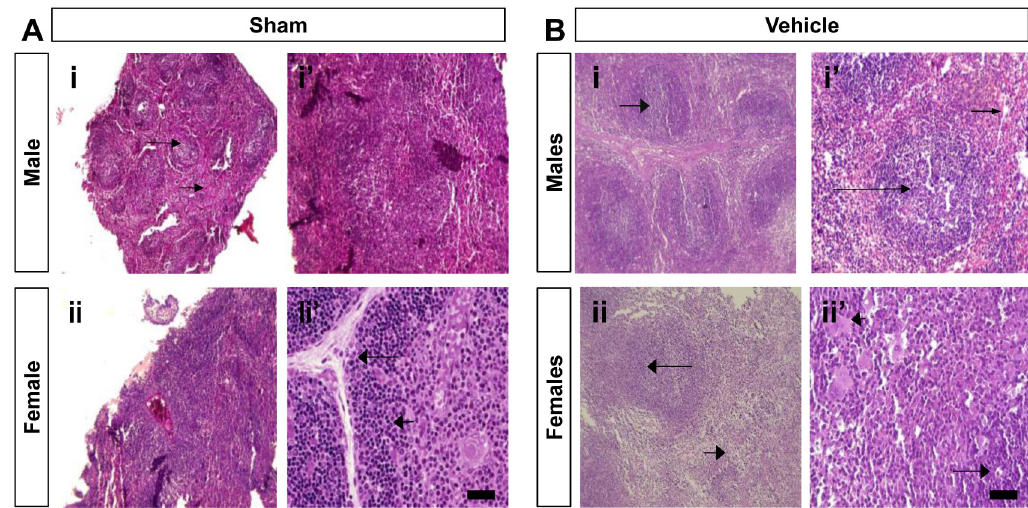
Fig 5. Histopathological analysis in hematoxylin and eosin (H&E) stained spleen of control and vehicle-treated mice (40 × ). (A) The splenic tissues of male and female control mice at lower magnification (panels Ai and ii) showed a typical structure of the spleen. The lymphatic nodules showed a prominent germinal center composed of the white pulp (long arrow) surrounded by splenic cords and venous sinuses composed of the red pulp (short arrow). The splenic tissues of male and female control mice (panels Ai’ and ii’) showed splenic trabeculae (long arrow) and lymphocytic aggregation and part of white pulp in the lymphatic nodules (short arrow). (B) The splenic tissue of male and female vehicle-treated mice at lower magnification (panels Bi and ii) showed lymphatic nodules with a prominent germinal center composed of the white pulp (long arrow). Also, at higher magnification, the splenic tissues of male and female vehicle-treated mice (panels Bi’ and ii’) showed white pulp composed of lymphatic nodules and prominent germinal center (long arrow) and red pulp composed of splenic cords and venous sinuses (short arrow).